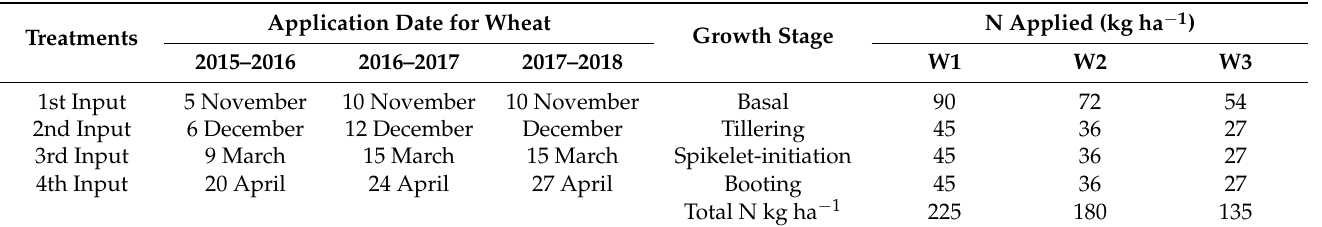
Table 1. Nitrogen application rates for the experimental treatments at various growth stages of wheat.